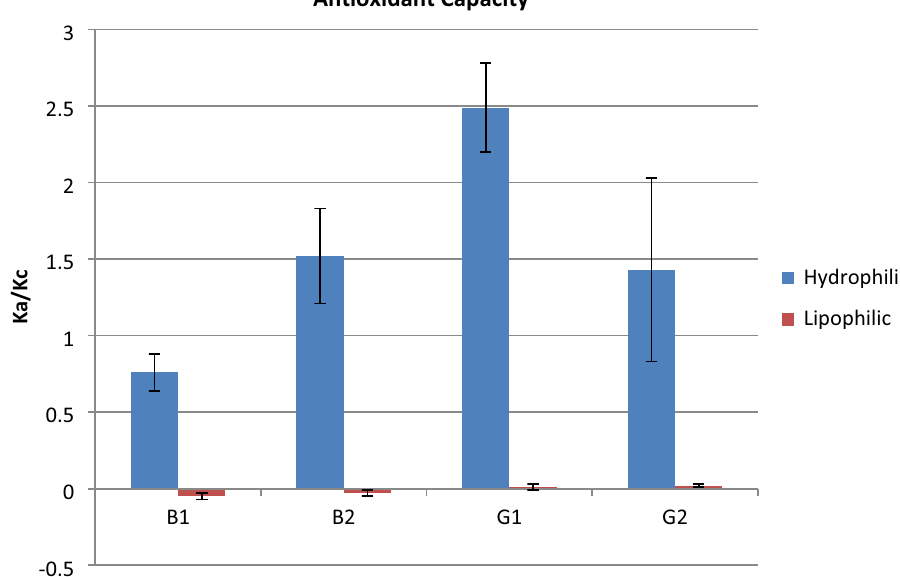
Figure 2. Level of aflatoxins antioxidant capacity. The result showed that, among the four aflatoxins, the antioxidant capacity was as follows: G 1 > B 2 > G 2 > B 1 . Moreover, aflatoxins demonstrated a higher antioxidant capacity in the hydrophilic environment, compared to the lipophilic one. Each value is the mean of three determinations ± S.D.